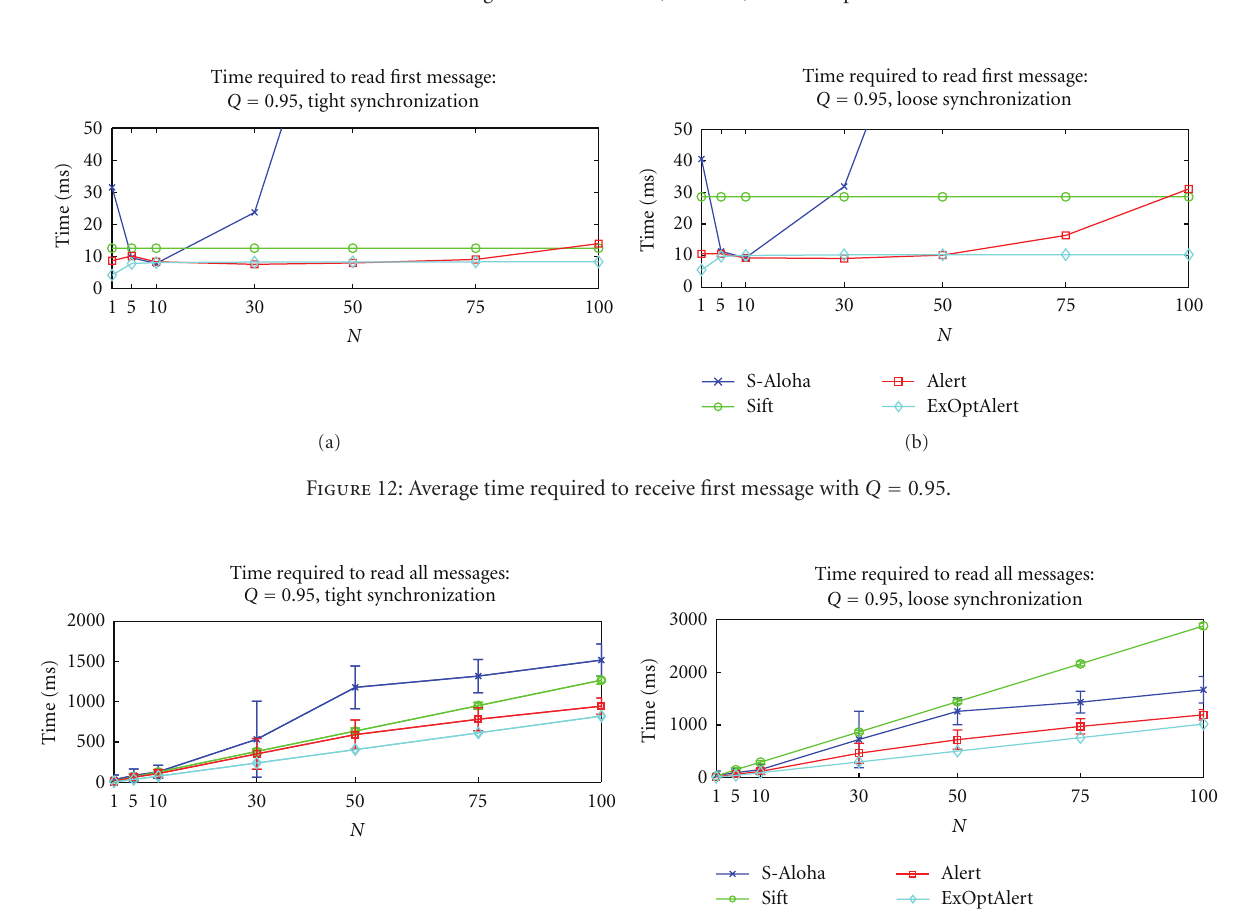
Figure 11: Timing within slots of Sift, S-Aloha, and Alert protocols.